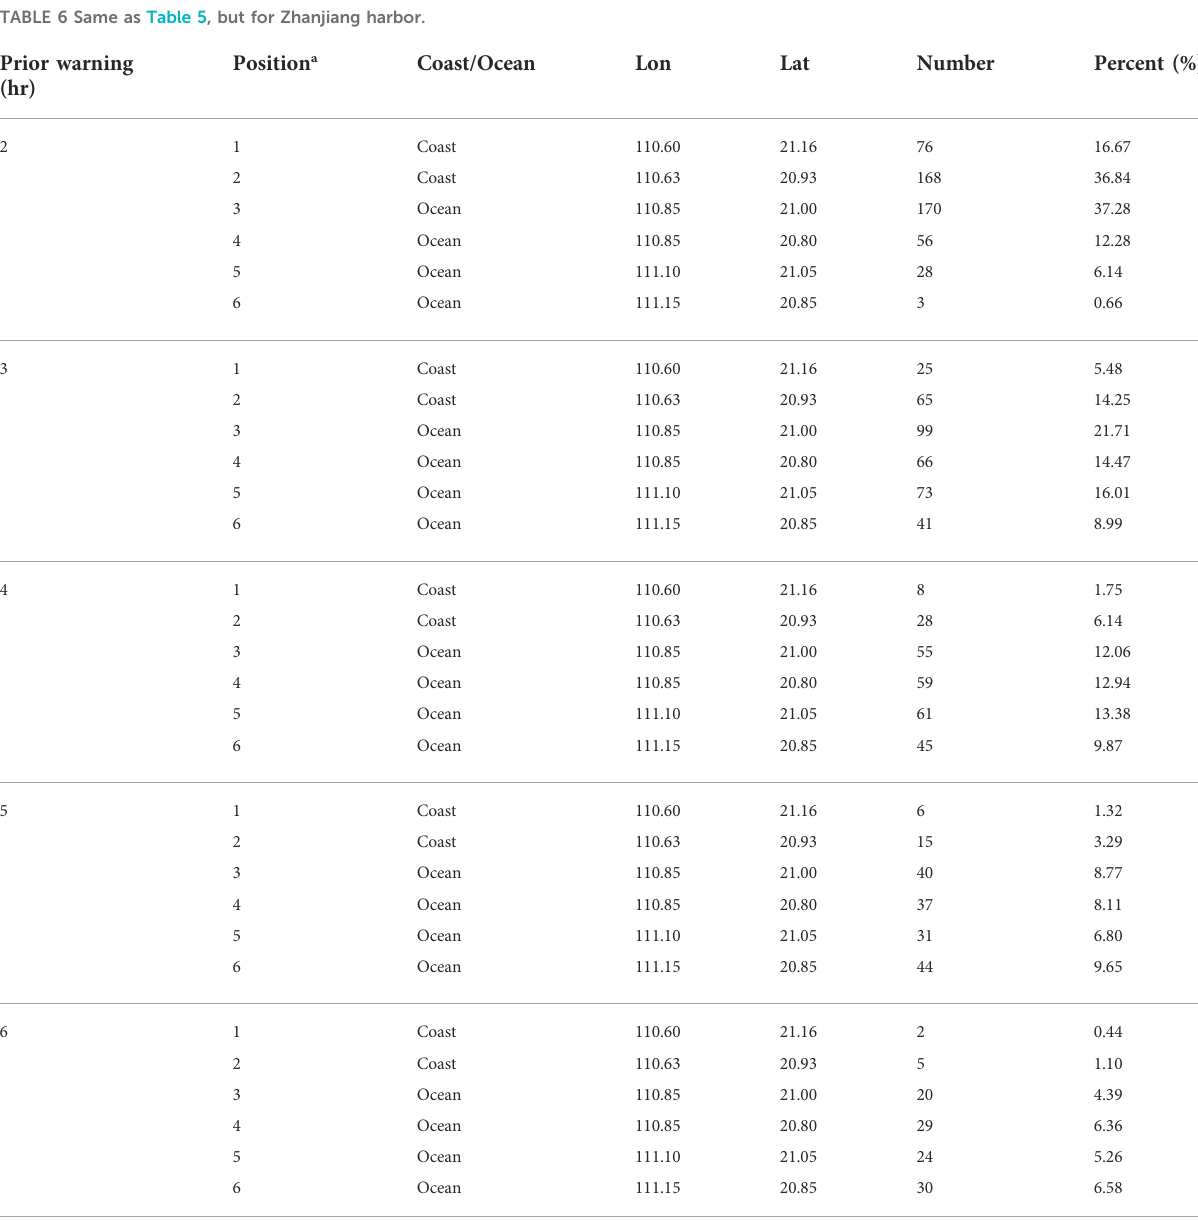
TABLE 6 Same as Table 5, but for Zhanjiang harbor. Prior warning